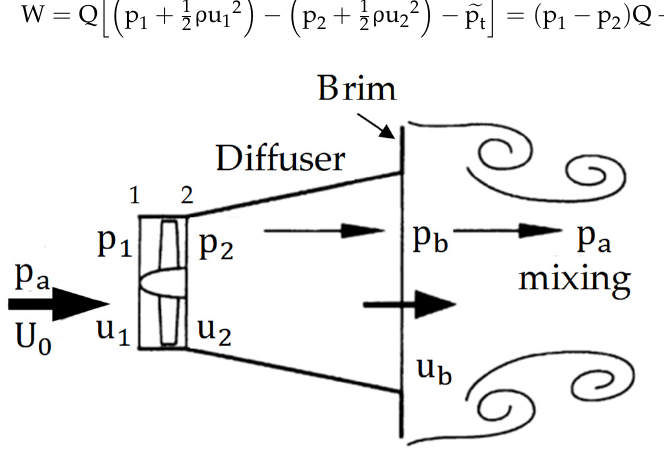
Figure 5. Configuration of wind turbine with brimmed diffuser.